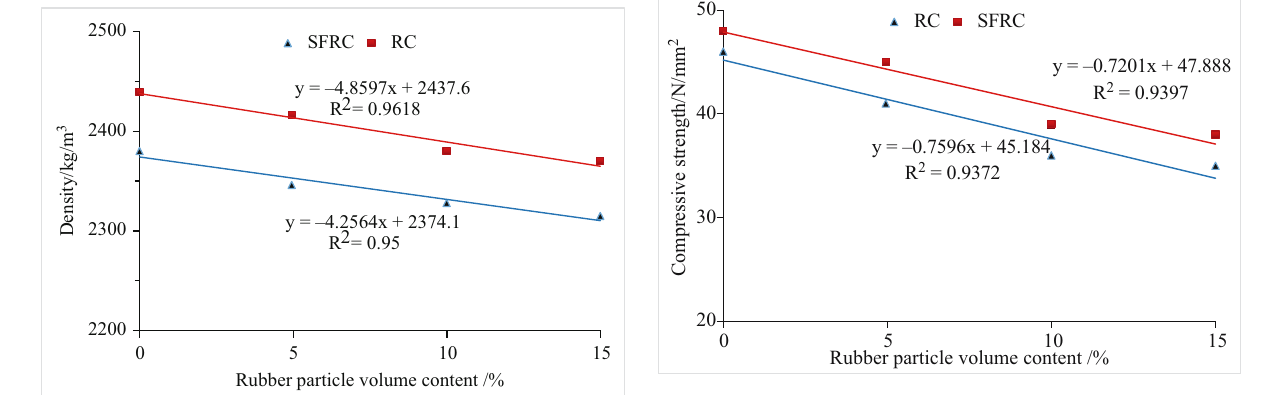
Figure 8: Cube compressive strength of concrete with di ff erent mix